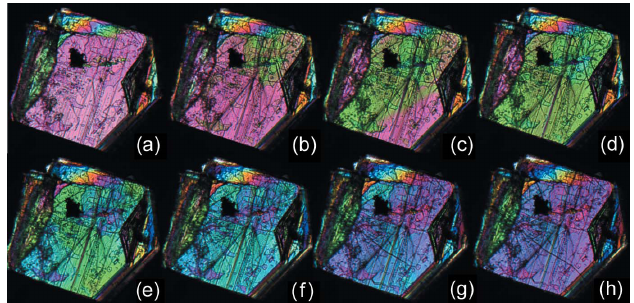
Figure 9 Polarisation images of a single crystal of dl -Nle ( (cid:7) 1 mm along the longest axis) at different temperatures during the (cid:2) ! (cid:6) transition. ( a ) 394.5 K (before the transition), ( b ) 394.6 K, ( c ) 394.6 K, ( d ) 394.7 K, ( e ) 394.7 K, ( f ) 394.7 K, ( g ) 394.9 K, ( h ) 394.9 K (the transition is complete).